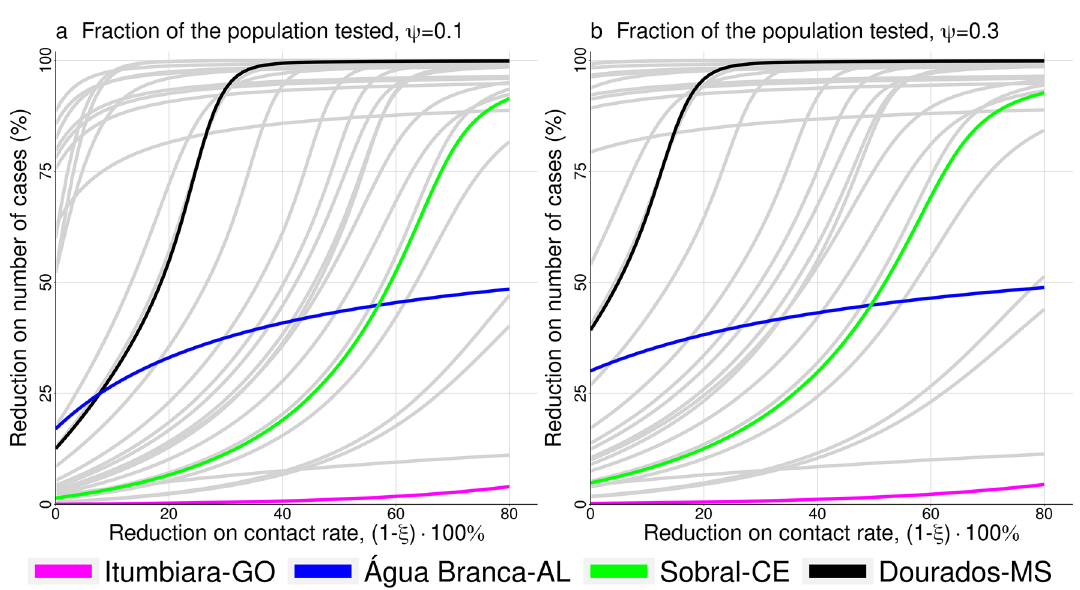
Figure 3. Reduction on the number of cases versus reduction on the contact rate, 1 − ξ , both in percentage. In ( a ), ψ = 0.1 and in ( b ), ψ = 0.3 ; where ψ is the fraction of the population tested. Among the 29